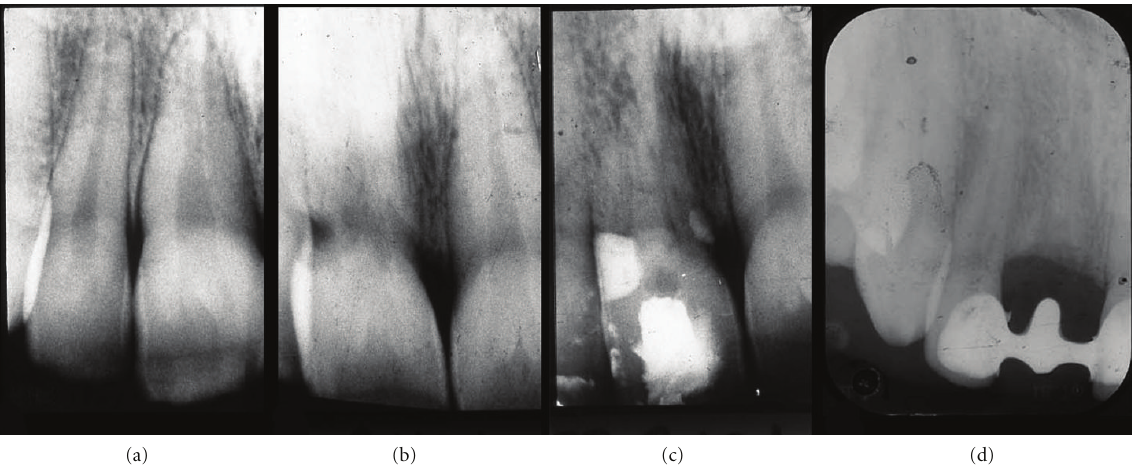
Figure 4: Patient 1: radiographs of the right maxillary central incisor region. (a) 1994. Seemingly normal periodontal conditions in the central incisor region. (b) 1997. Severe cervical resorptions have appeared in the central incisor. (c) August 1999. Severe resorption of the root of the maxillary central incisor. The condition resulted in extraction of the central incisor. (d) December 1999. The maxillary central incisor has been extracted and the alveolar bone level is